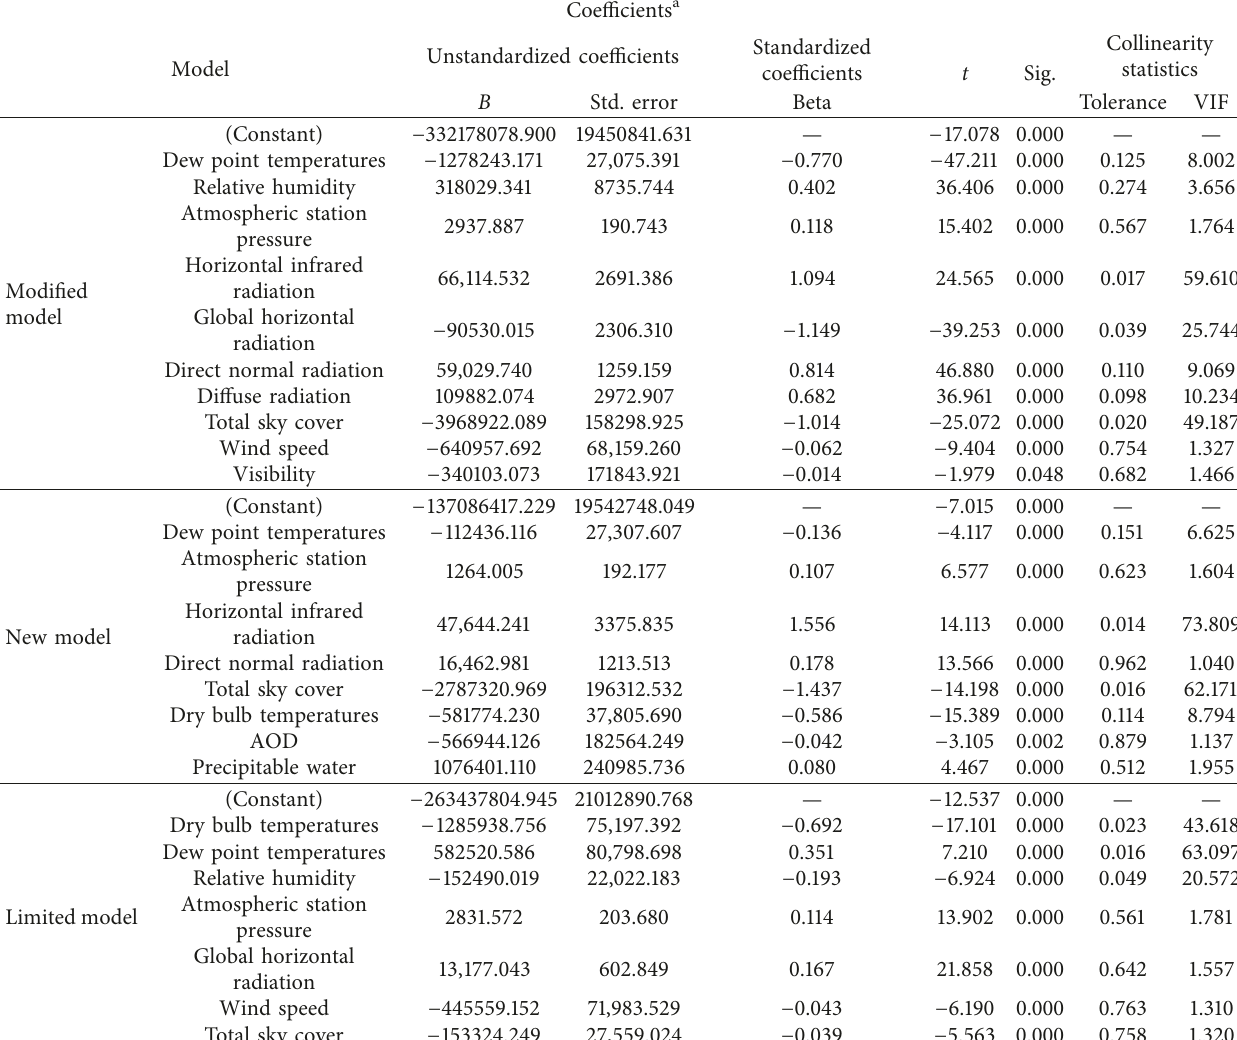
Table 17: Regression coefficients for a DOE medium office building depending on different models.